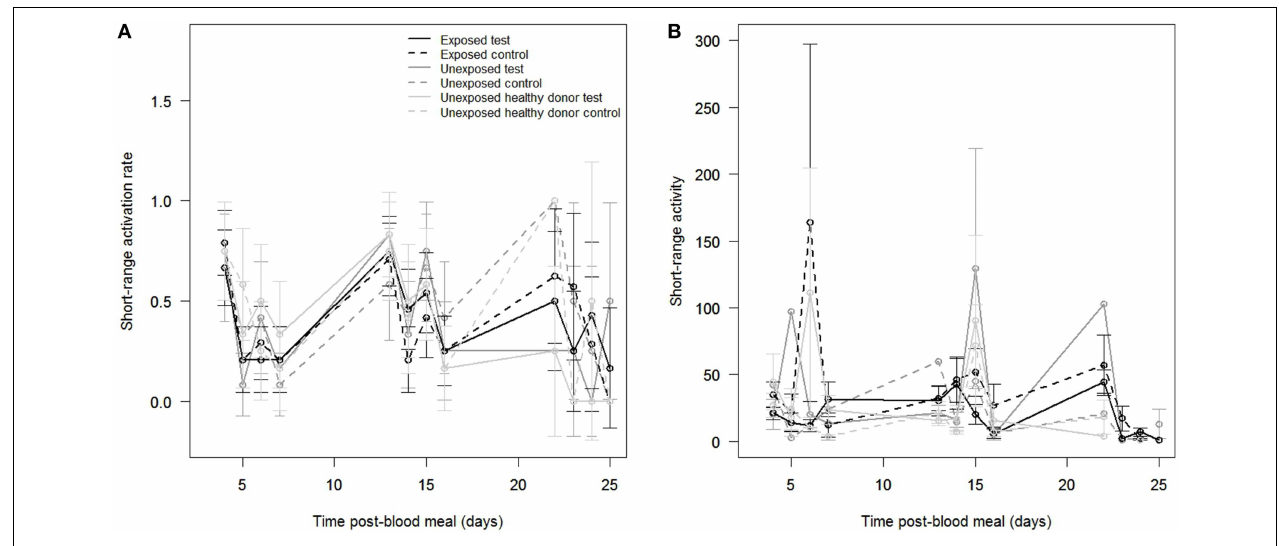
FIGURE 5 | Mosquito short-range behavioral responses (assay II). Effects of time post-blood meal, blood meal type and odor stimuli on (A) the short-range activation of mosquito females, expressed as the proportion of mosquitoes that crossed at least